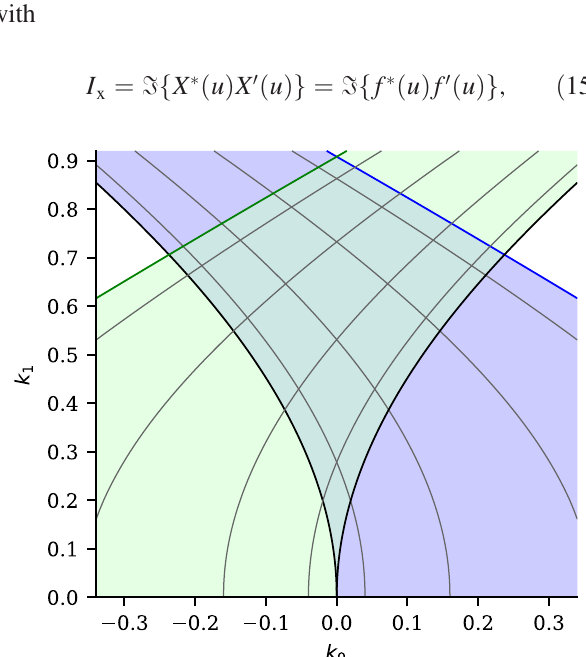
FIG. 2. Stability diagram for the neck-tie island. Shading and colored lines like in Fig. 1. Gray lines are isolines of ν steps of